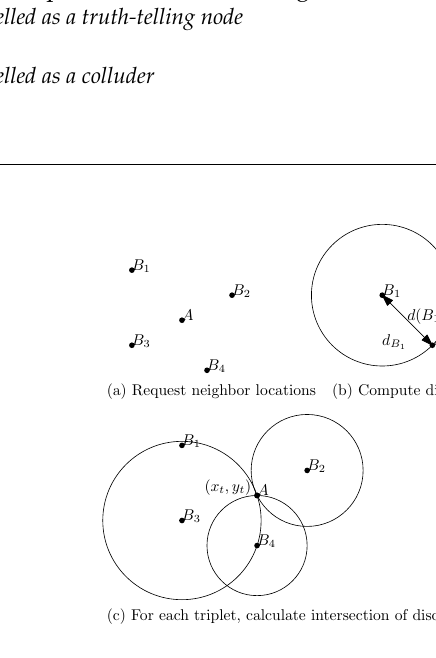
Figure 2. Detailed example: ( a ) In this example, sensor A has four neighbours, i.e., K contains B 1 , B 2 , B 3 and B 4 . For i = 1, 2, 3, 4, sensor A (1) requests and gets the location ( x i , y i ) of every neighbour B i ; and (2) derives each self-to-neighbour B i distance. ( b ) Using the location of every neighbour B i and distance ( d ( B i , A ) ), a disc is calculated ( d B ). Here this is shown for neighbour B 1 . ( c ) For each i possible triplet t over the set of discs obtained in ( b ), calculate the intersection point ( x t , y t ) of this triplet of discs. This is shown here for t equal to { B 2 , B 3 , B 4 } . In this example, there are four possible combinations of three, that is, four triplets. Assuming here that all neighbours are truth-tellers and mutually within communication range, they will be all in agreement (up to this point: Lines 1 to 4 of Algorithm 1). The CCL of A contains B 1 , B 2 , B 3 and B 4 , and their coordinates (Lines 6 to 8 of Algorithm 1). The CCLs obtained from neighbours are all consistent (Lines 9 to 11 of Algorithm 1). Each neighbour is consistently listed in three CCLs of neighbours. For example, B 1 is listed in the CCLs of B 2 , B 3 and B 4 , with the same coordinates. Each neighbour gets a score of 3 (Lines 12 to 18 of Algorithm 1). Consequently, each neighbour is labelled truth-teller (Lines 19 to 25 of Algorithm